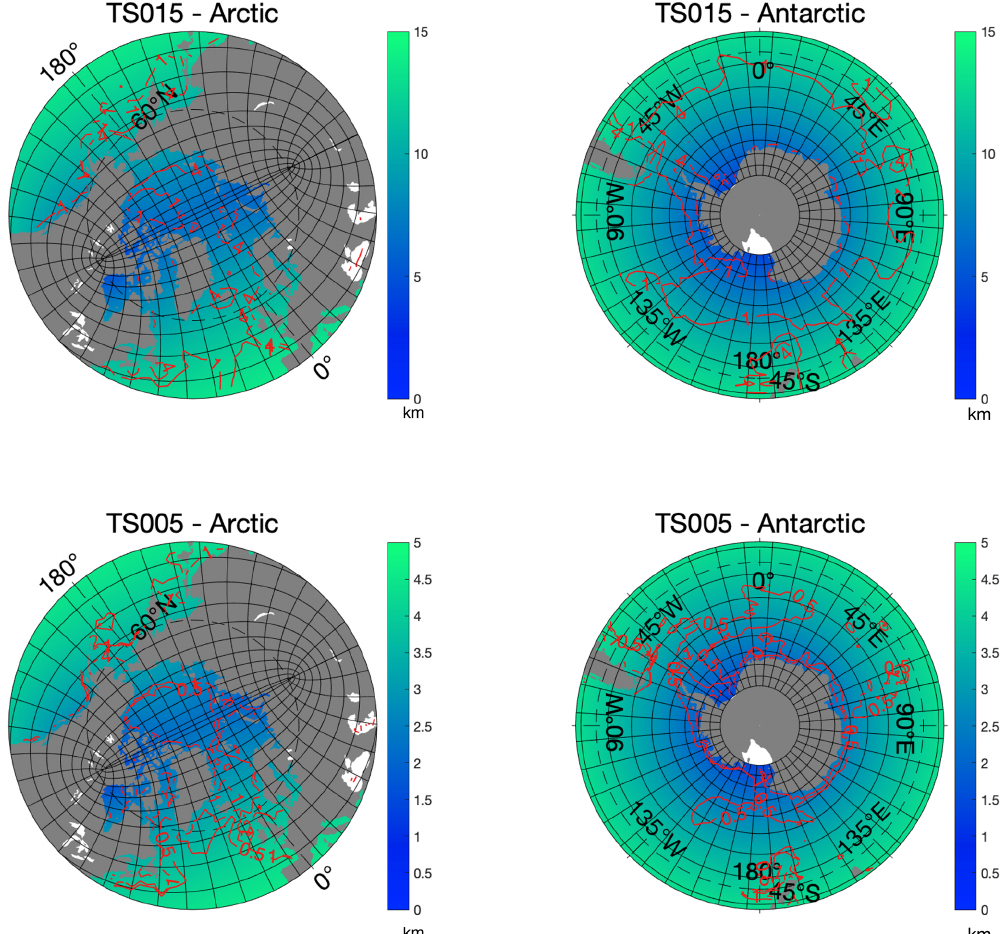
Figure 3. Horizontal grid scale of TS015 and TS005 in the polar regions. For grid lines, 1 in 60 (or 180) points is shown for the TS015 (cid:112) ( d x 2 + d y 2 )/ 2 is shown by filled contours (in kilometers), and regions of mesoscale-resolving capability ( s/R < 0 . 5) are (or TS005) grid. outlined by red contour